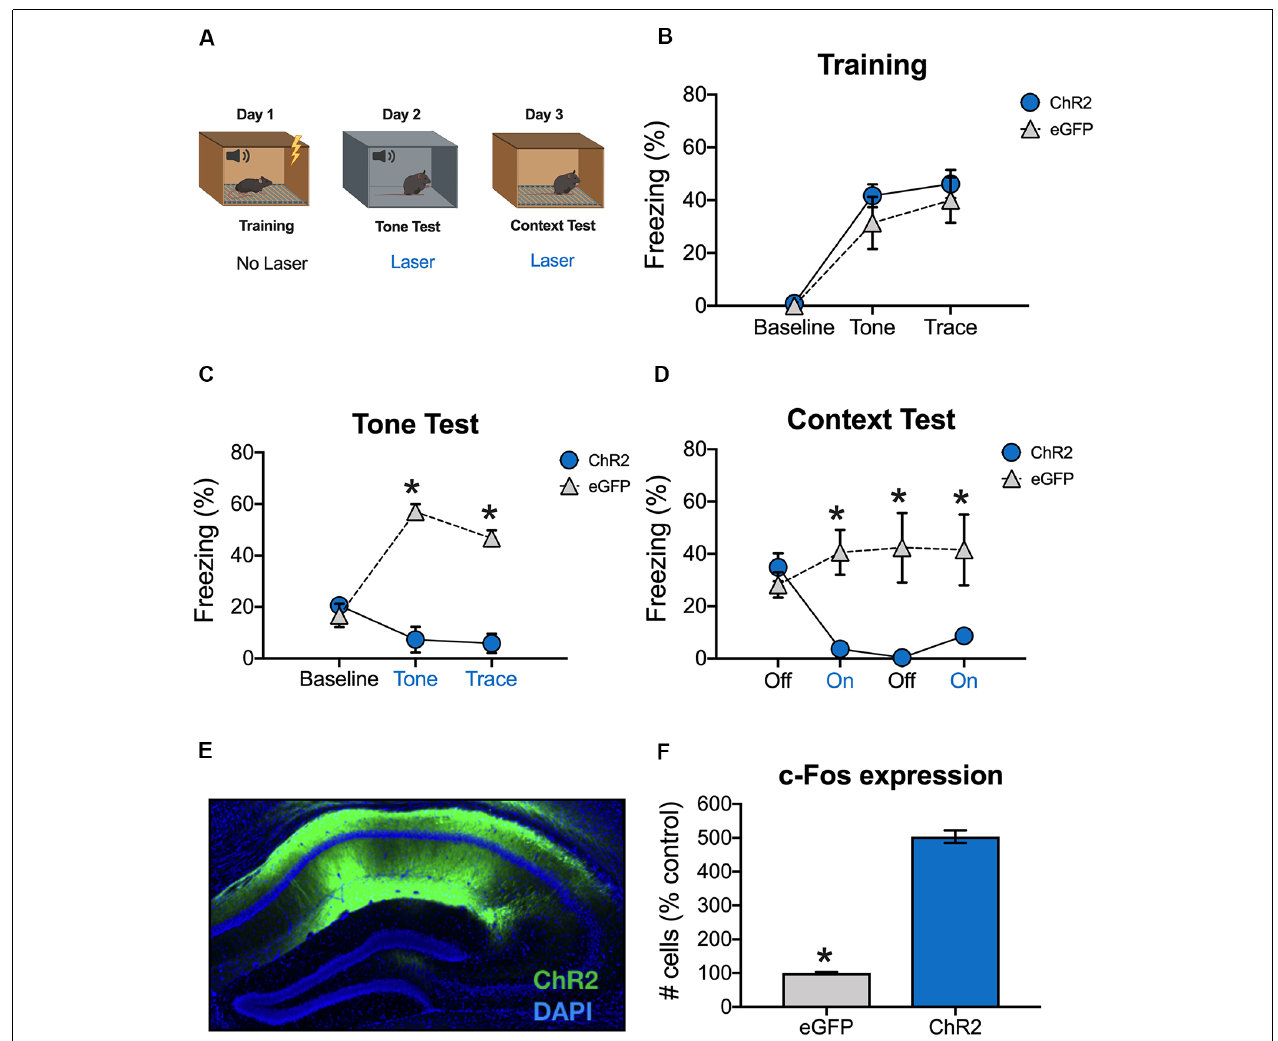
FIGURE 2 | Stimulation of dCA1 impairs trace fear memory retrieval. (A) Schematic of behavioral paradigm. On day 1, animals underwent trace fear conditioning without laser stimulation. The next day, mice underwent a tone memory test in a novel context with blue light delivered (20 Hz) to dCA1 during each trial. Twenty-four hours later, mice were placed back in the conditioning environment for a context memory test. The laser was not turned on for the first 3 min of the context test. Then, blue light was delivered to dCA1 for the next 3 min, followed by another 3 min laser off period, and a last 3-min laser on epoch. (B) Freezing during the training phase of trace fear conditioning (Mean ± SEM). (C) Freezing during the tone test (Mean ± SEM). (D) Freezing during the context test (Mean ± SEM). (E) Example of virus expression. Green, ChR2; Blue, DAPI. (F) c-Fos expression in eGFP and ChR2 mice after the context test. Blue x-axis labels denote periods during which the laser was delivered. In all panels, blue represents the ChR2 group and gray represents the control group. ∗ p < 0.05 relative to